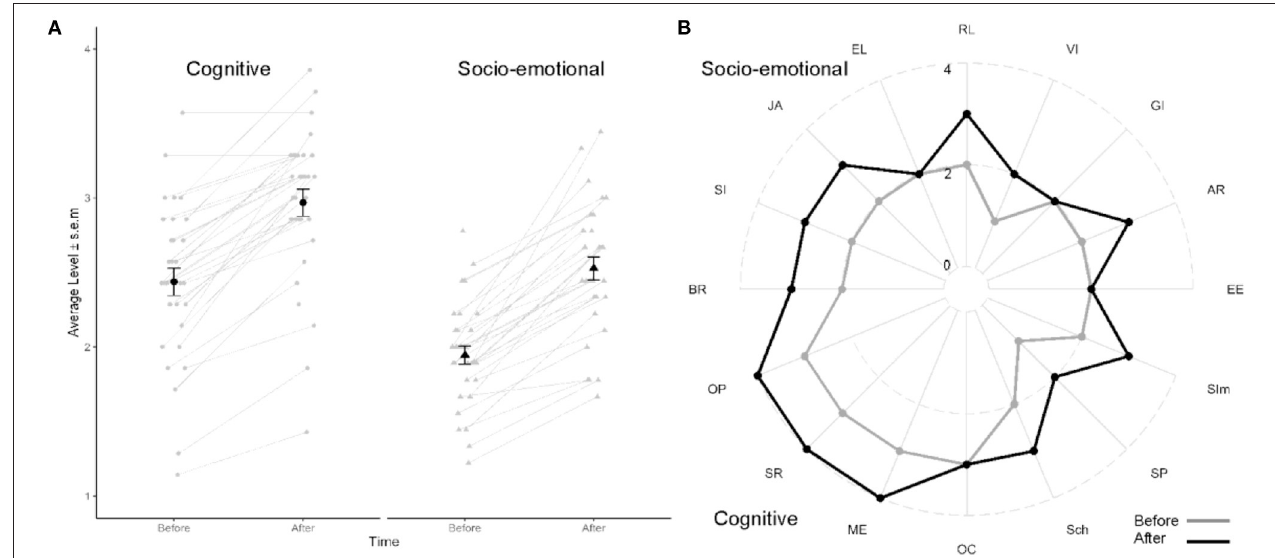
FIGURE 1 | Cognitive and socio-emotional assessment. (A) Average level across all cognitive and all socio-emotional domains before and after 9 months of therapy. Each individual is plotted as a gray line. Black dots represent group mean ± standard error of mean. Note that participant 28 was the participant producing the lowest scores; however, a progression was also observed with therapy. (B) Radar plot of statistical mode for each domain assessed with SCEB. Socio-emotional are presented on top and cognitive domains on bottom of image. Grayline, before therapy; black line, after therapy. Socio-emotional domains: BR, behavior regulation; SI, social interaction; JA, joint attention; EL, expressive language; RL, receptive language; VI, vocal imitation; GI, gestural imitation; AR, affective relation; EE, emotional expression. Cognitive domains: SIm, self-image; SP, symbolic play; Sch, object-relation schemata; OC, operational causality; ME, means–ends; SR, spatial relations; OP, object